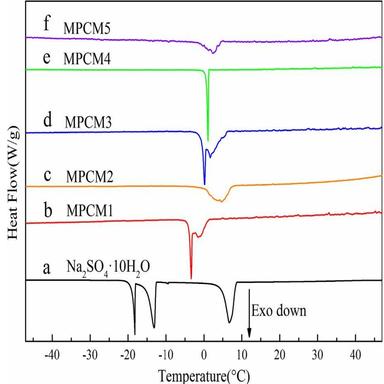
Solidifying DSC curves of (a) Na2SO4·10H2O and (b–f) MPCM1–MPCM5.